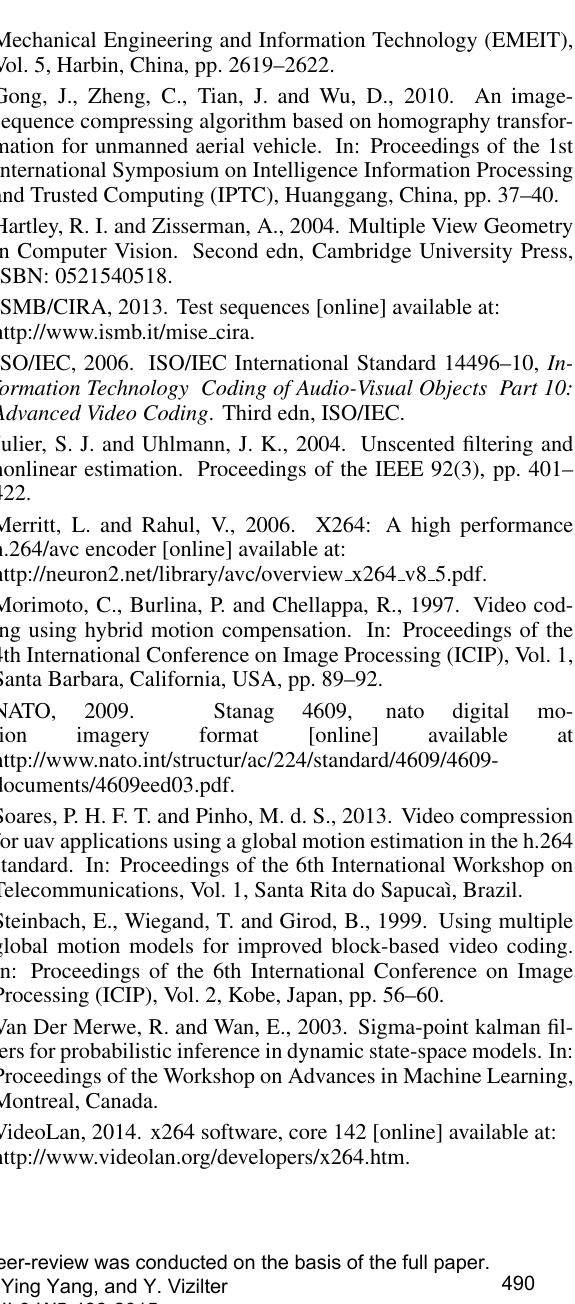
Figure 13: R-D curves for the ”Brezza” sequence, with a resolu- tion of 3000x2000 pixels and a frame rate of 1